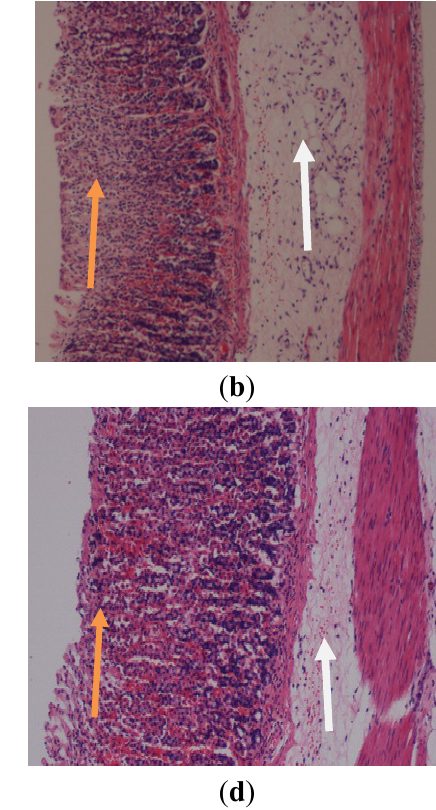
Figure 3. Histological study of the absolute ethanol-induced gastric mucosal damage in rats. ( a ) Rats pre-treated with CMC (normal control). No disturbance of gastric mucosa. ( b ) Rats pre-treated with CMC (ulcer control). There is severe disruption to the surface epithelium and necrotic lesions penetrate deeply into mucosa (orange arrow) and extensive edema of submucosal layer and leucocytes infiltration are present (white arrow). ( c ) Rats pre-treated with omeprazole (20 mg/kg). Very mild disruption of the surface epithelium mucosa is present, but deep mucosal damage is absent. ( d ) Rats pre-treated with P. jiringa (250 mg/kg). There is moderate disruption to the surface epithelium (orange arrow) with edema and leucocyte infiltration of the submucosal layer (white arrow). ( e ) Rat pre-treated with P. jiringa (500 mg/kg). Mild disruptions of surface epithelium are present but deep mucosal damage is absent (orange arrow). There is slight edema with leucocyte infiltration of the submucosal layer (white arrow) (H&E stain